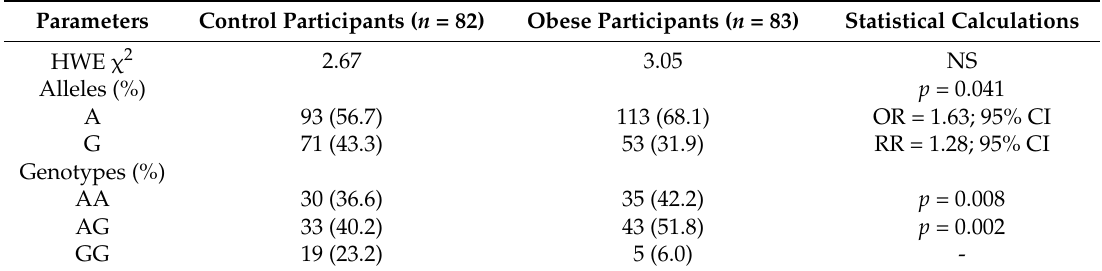
Figure 3. Rs1761667 genotypes separated on 2% agarose gel and stained with ethidium bromide. The blot shows one identical photograph from several reproduced ones. Table 2. Genotype and allelic frequencies of CD36 rs1761667 between control and obese participants.